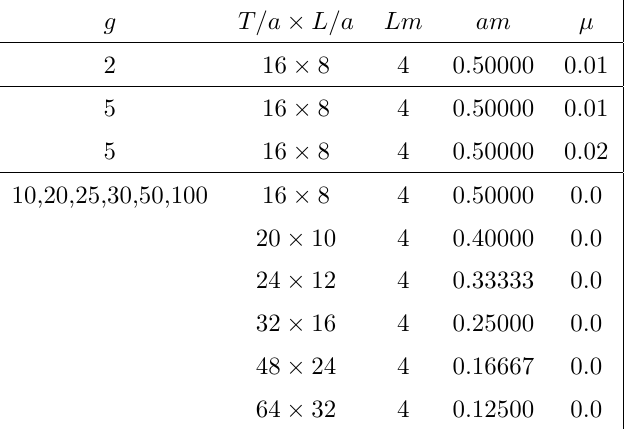
Table 1 . The parameters of our simulations are the coupling g , the temporal ( T ) and spatial ( L ) extent of the lattice in units of the lattice spacing a . The mass parameter am is given by the (cid:12)xing the combination Lm = 4. The reweighting parameter (cid:22) is non-zero only for g < 10. from the connected two-point